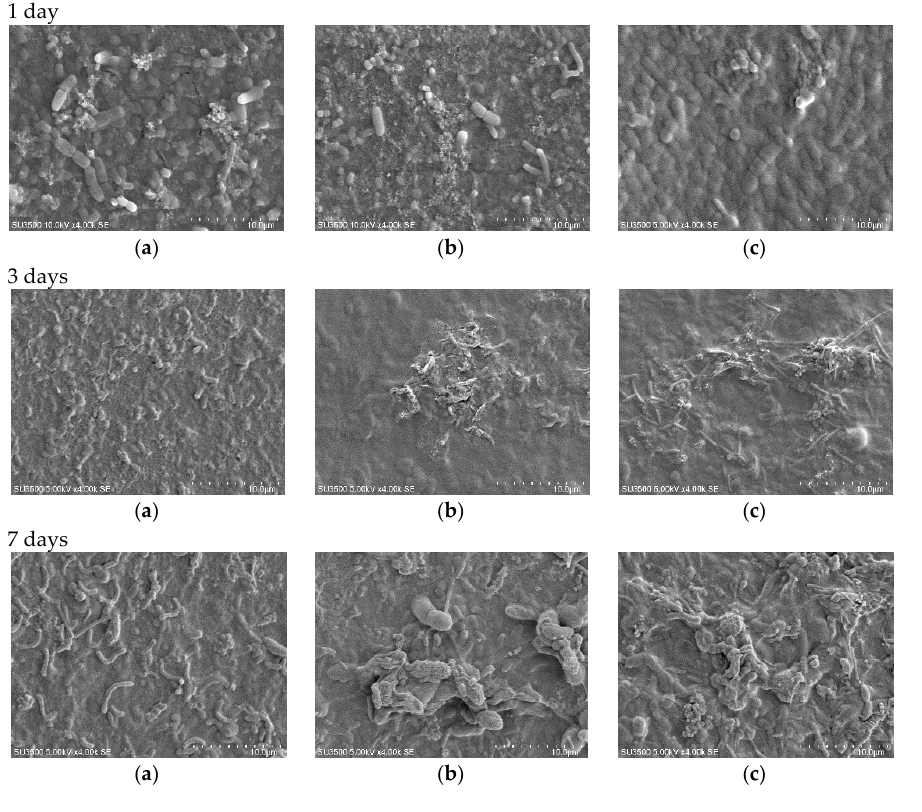
Figure 9. SEM images representing bacterial growth and attachment on ( a ) pure PVDF, ( b ) PVDF15, and ( c ) PVDF30 after immersion in a mixed culture from 1 day to 7 days with 4000× magnification. Scale bar: 10 μ m.